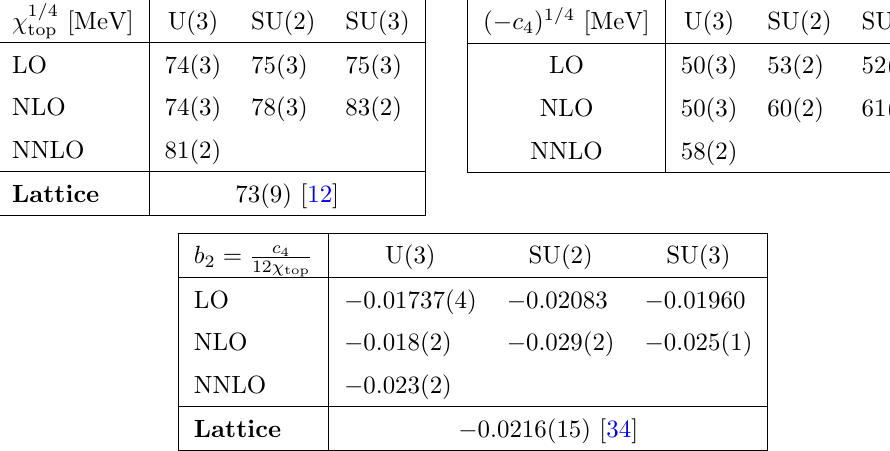
Table 1 . Topological susceptibility, fourth-order cumulant and the b 2 coe(cid:14)cient, calculated in SU(2), SU(3) and U(3) ChPT to LO, NLO and NNLO in the isospin limit. The lattice values mentioned in the main text have been also quoted here for reference. The numerical values of the masses, decay constants and LECs involved, as well as their uncertainties, are taken from [48], except L 25 , v (0) and v (0) , which are set to zero, (see main 2 4